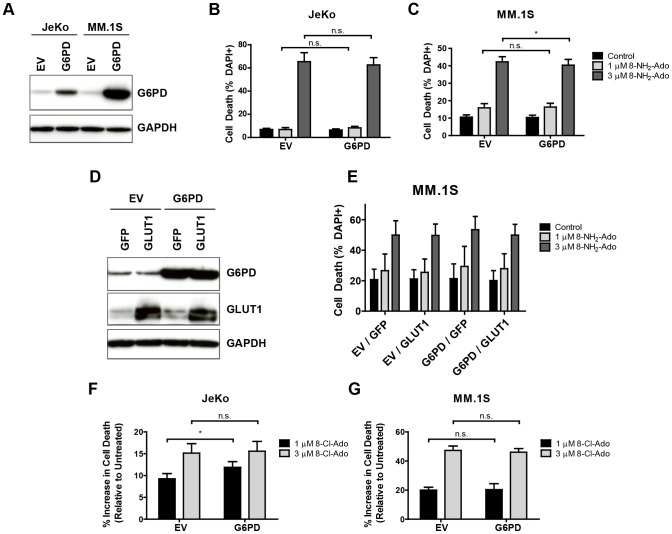
Ectopic expression of G6PD with and without GLUT1 is insufficient to abrogate 8-NH2-Ado sensitivity.(A) Sensitive cell lines were transduced with lentivirus harboring an empty vector control (EV) or G6PD cDNA (G6PD) and stable cell lines were generated. G6PD protein expression was analyzed by immunoblotting. A representative blot from three independent experiments is shown. (B) JeKo and (C) MM.1S stable cell lines were treated for 17 hours with the indicated concentrations of 8-NH2-Ado. Cell death was assessed solely by DAPI staining (n = 3 for JeKo, n = 5 for MM.1S). (D) MM.1S empty vector- and G6PD-expressing stable cell lines were transduced with GFP or GLUT1 cDNAs. G6PD and GLUT1 expression was analyzed by immunoblotting. A representative blot from three independent experiments is shown. (E) Cells from part (D) were treated for 17 hours with the indicated concentrations of 8-NH2-Ado. Cell death was assessed solely by DAPI staining (n = 3). (F) JeKo and (G) MM.1S stable cell lines were treated for 48 hours with the indicated concentrations of 8-Cl-Ado. In parts (F)–(G), cell death was assessed solely by DAPI staining (n = 5 for JeKo, n = 3 for MM.1S) and data represent the increase in cell death relative to untreated cells (normalized to 0%). Data in parts (B), (C), and (E)–(G) are means ± SEM. Statistically insignificant differences are indicated by n.s. except in part (E) in which all differences between cells receiving identical treatments were not statistically significant. * P<.05 ** P<.01 *** P<.005.